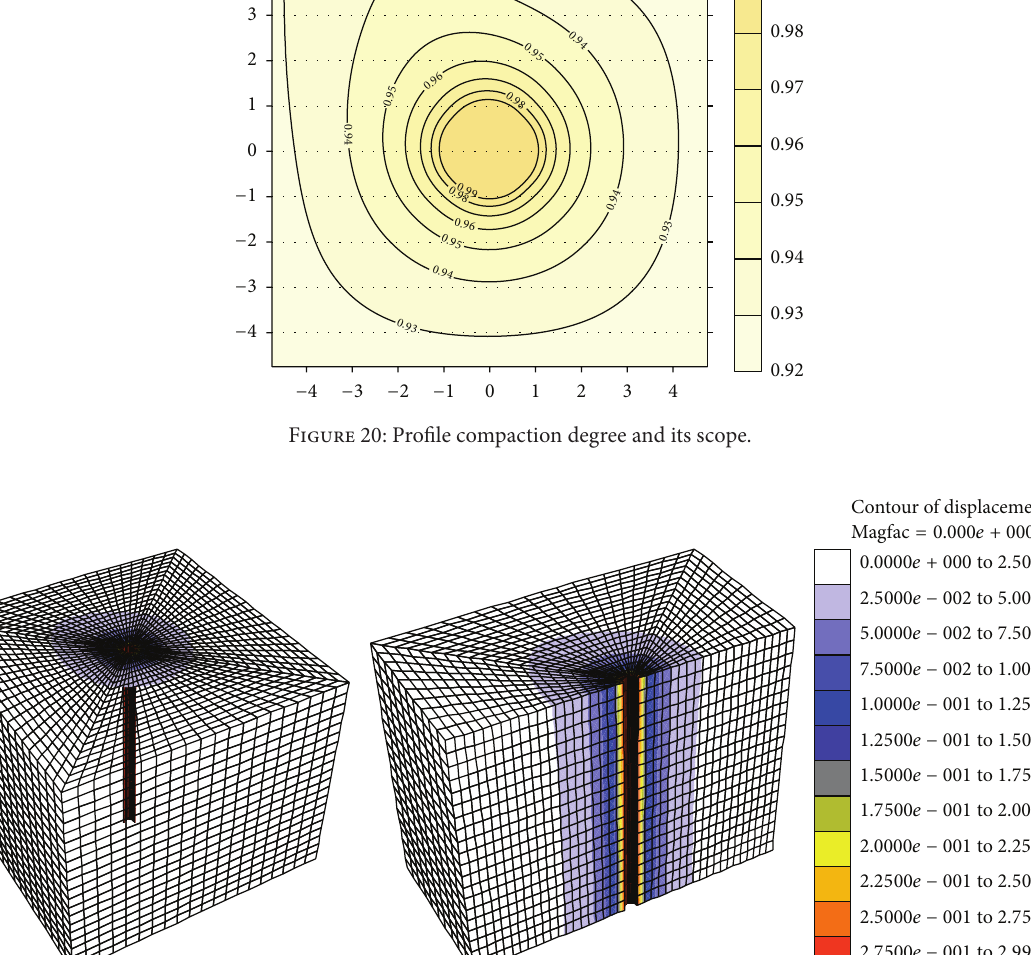
Figure 21: 3D maximum displacement